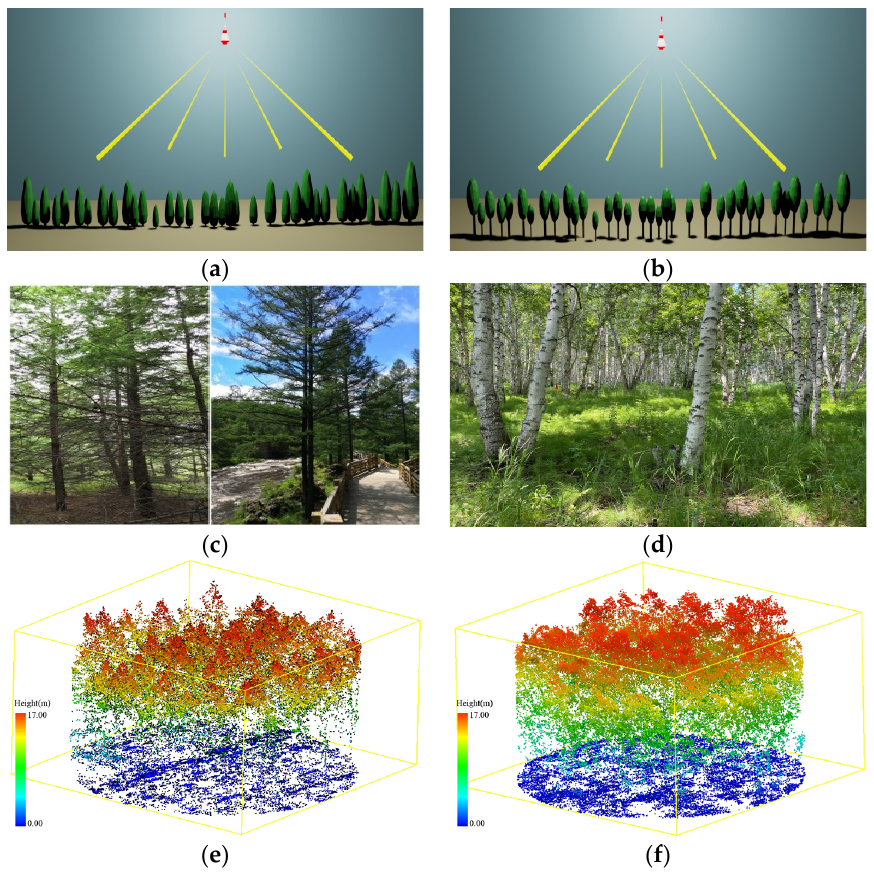
Figure 1. The examples shown in ( a , c , e ) and ( b , d , f ) are 3D models, real photos, and the point cloud data of coniferous and broadleaf forests, respectively. The black shaded area in Figure 1a,b is the LiDAR effect area (LEA).